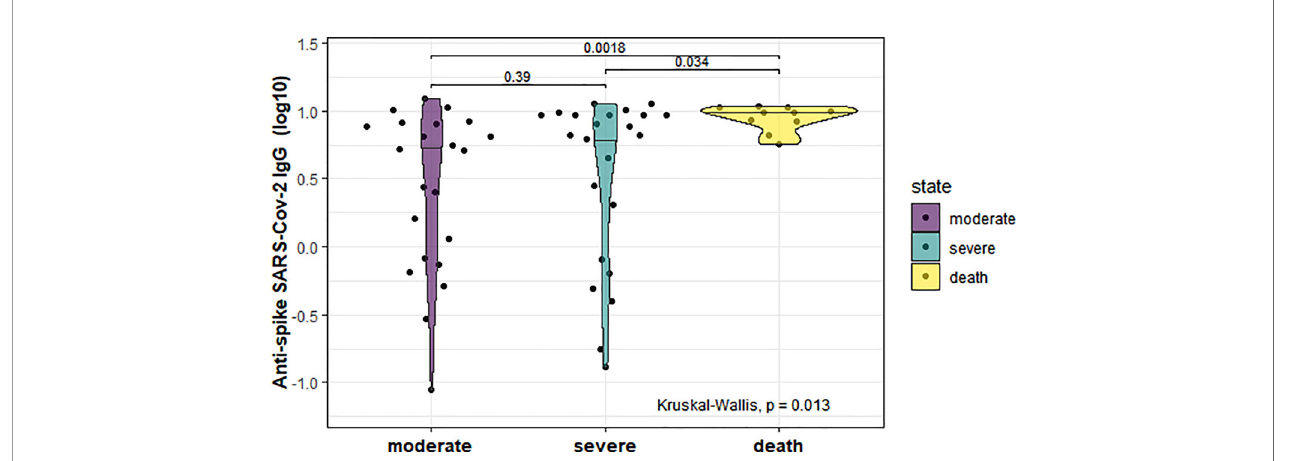
FIGURE 1 | Serum anti-spike IgG concentrations in the three study groups (moderate, severe and deceased) of hospitalized COVID-19 patients at baseline. The median is shown in different violin groups of biomarkers. P-values were computed by the Kruskal-Wallis test and a post-hoc analysis by Dunn ’ s